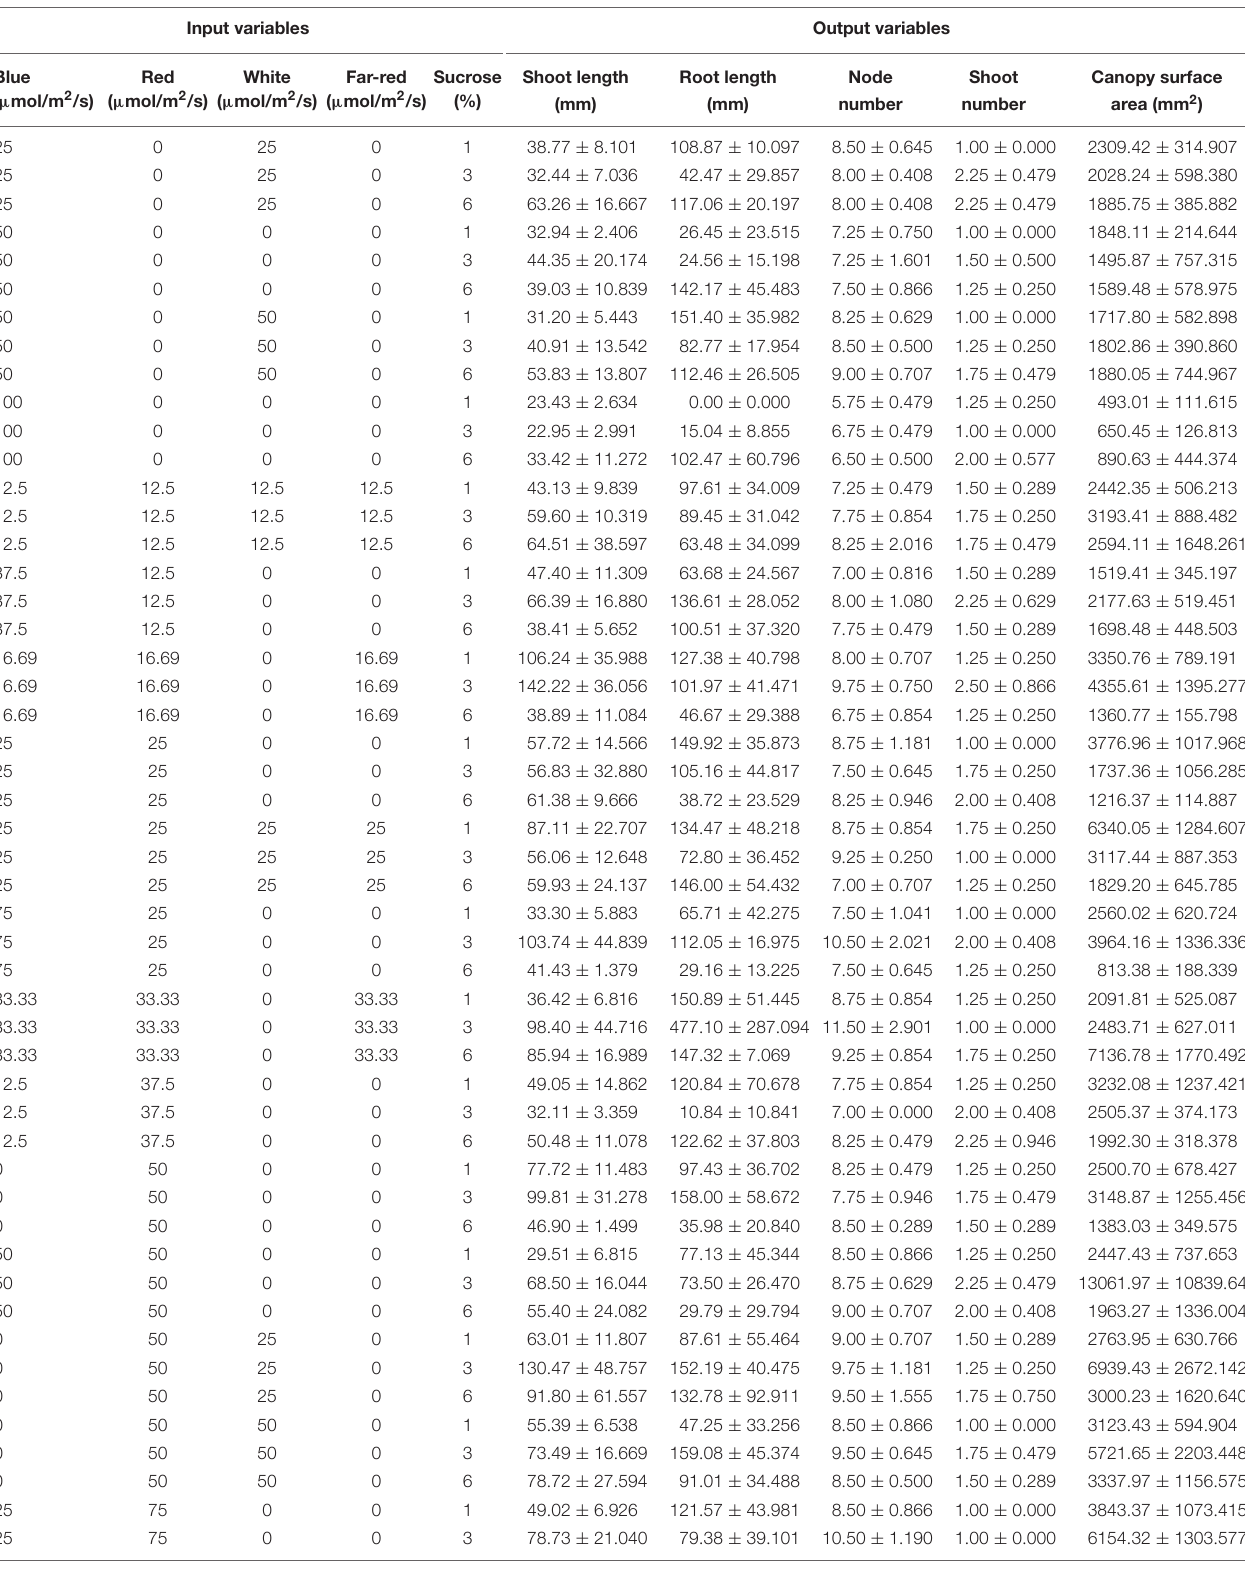
TABLE 1 | Effect of light and carbohydrate on in vitro Cannabis shoot growth and